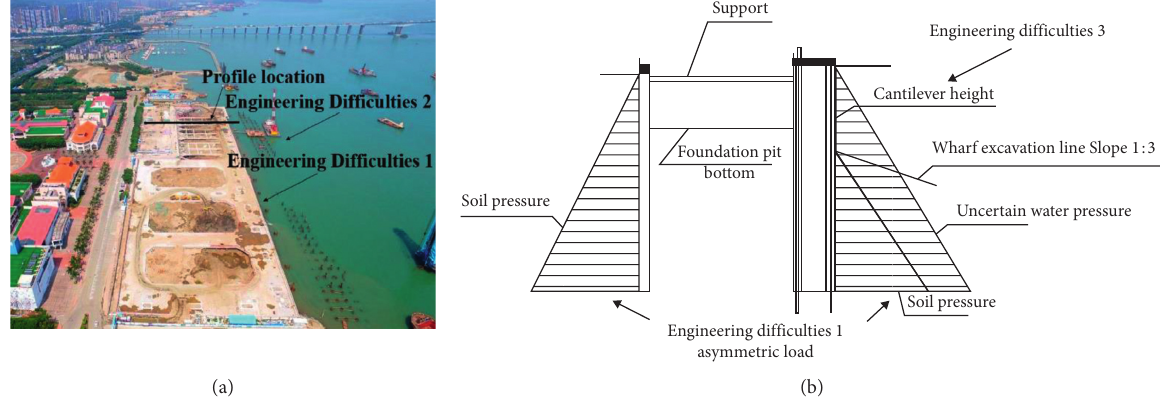
Figure 10: Plane and section location map of engineering difficulties.